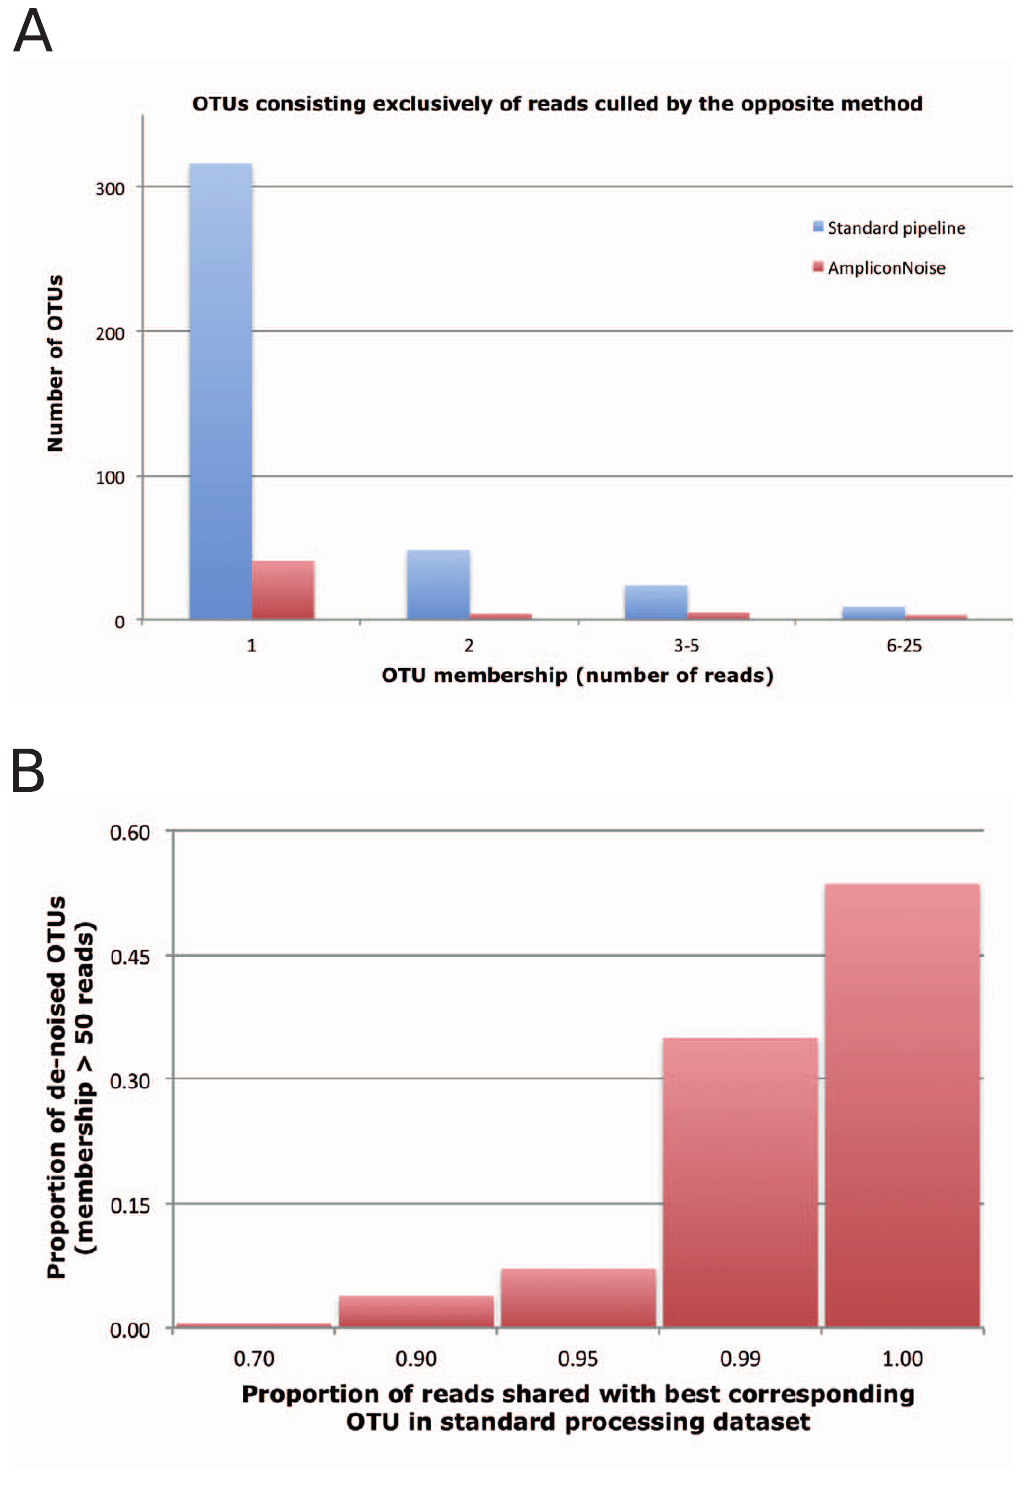
Figure 1. Corresponding OTUs between data processing methods. A) Each method generated some OTUs which consist entirely of sequence reads that were culled in the alternate method. These inconsistent OTUs were mostly singletons and were more abundant in the standard pipeline. B) Most OTUs had a clear corresponding OTU in the alternate method. Data shown are OTUs having a membership . 50 reads in the AmpliconNoise dataset, and the proportion of the membership of each OTU that was shared with the best corresponding OTU in the standard pipeline dataset.